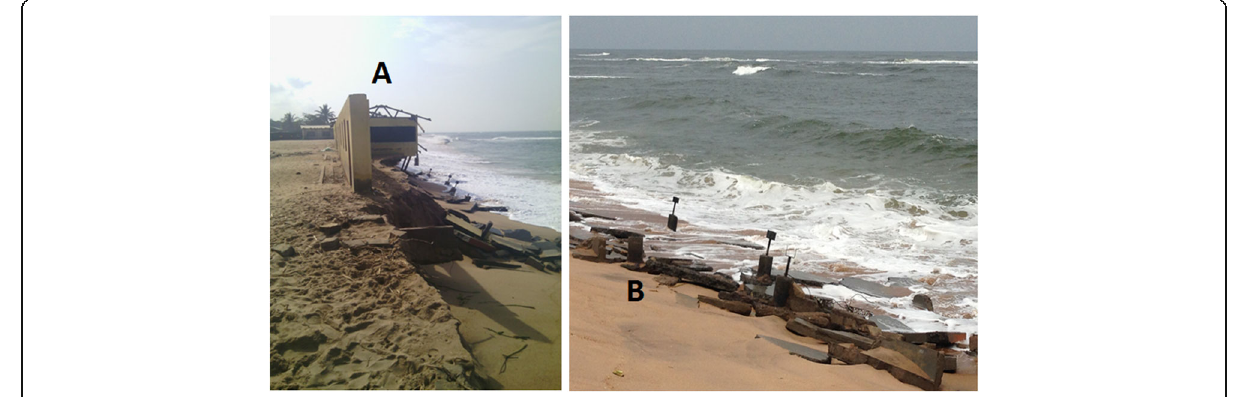
Fig. 7 State of the school building in May 2016 ( a ) and June 2016 ( b